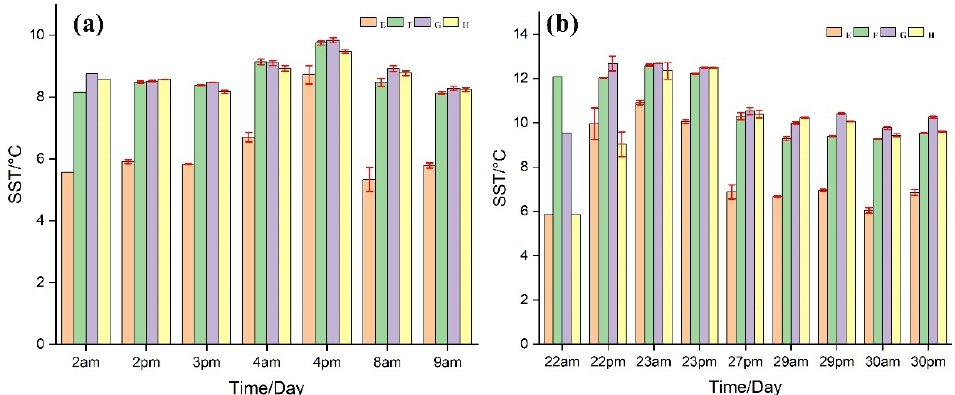
Figure 7. The effect of the cold wave process on the SST in the Yangtze Estuary (where ( a , b ) corre- spond to the cold waves in January 2015 and December 2021, respectively; E, F, G, and H correspond to the North Branch, South Branch, North Passage, and South Passage waters of the mouth of the Yangtze River, respectively; and the length of the red error bars represent the magnitude of the temperature